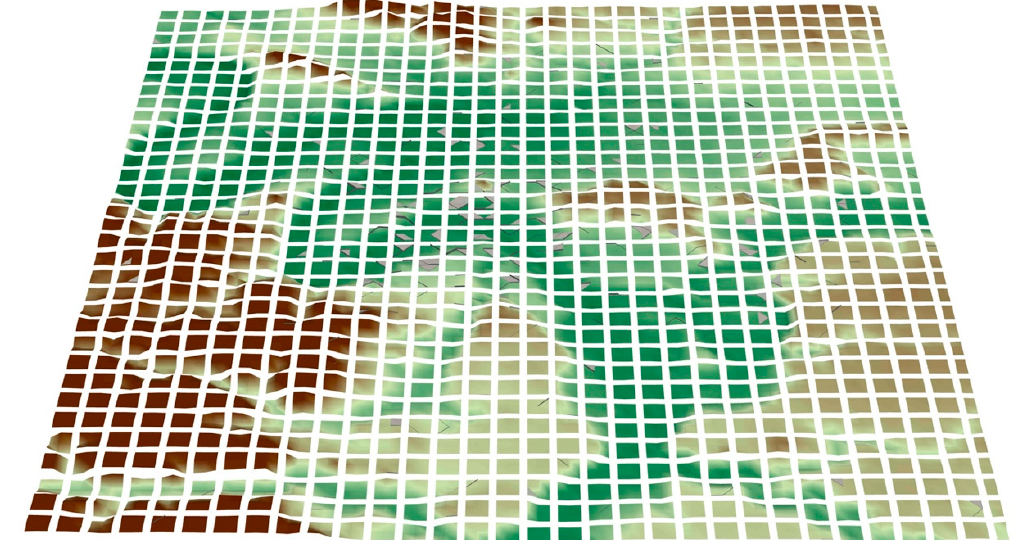
Figure 4. Domain decomposition of the domain in 1088 tiles.